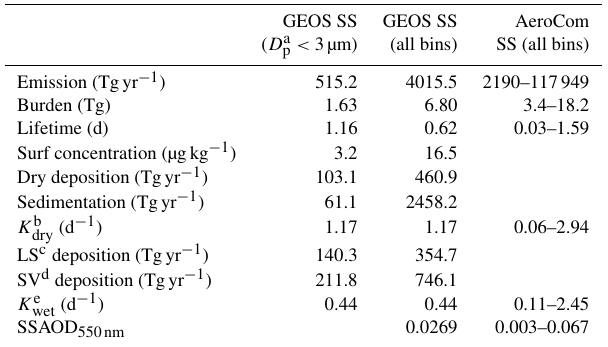
Table 1. Sea salt (SS) budget analysis on annual basis from July 2016 to June 2017 (second column: GEOS SS up to 3µm in dry diameter; third column: GEOS SS for all bins; fourth column: AeroCom SS for all